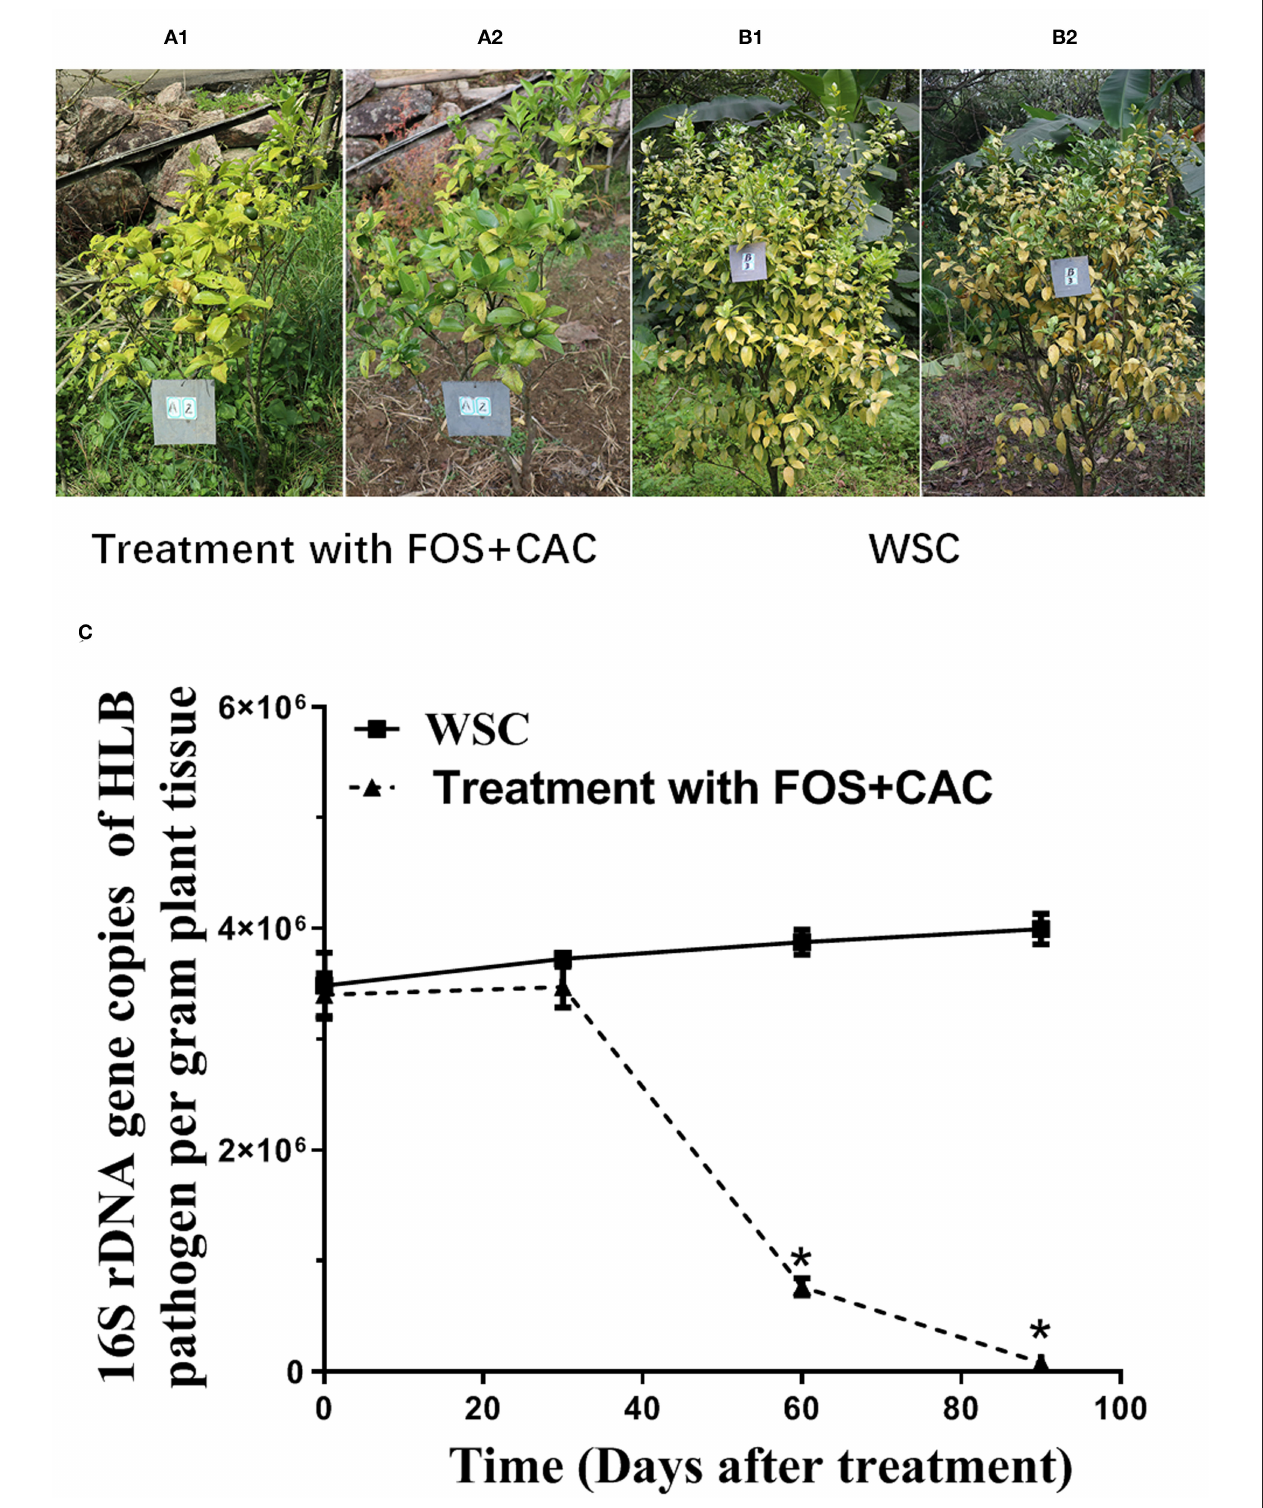
FIGURE 3 | Combination of FOS and CAC effectively relieved citrus HLB after 3 months treatment in the orchard. (A) HLB-affected citrus after 3 months treatment. A1: before treatment; A2:3 months after FOS and CAC treatment. (B) HLB-affected citrus after 3-month without treatment. B1: before treatment; B2:3 months after water treatment. (C) 16S rDNA gene copies of Ca .Las per gram plant leaves midrib during 3 months in the orchard. Standard curve were obtained: Y = − 0.310X + 10.927, R 2 = 0.9965, Y represents 16S rDNA gene copies of HLB pathogen, X represents Ct value. WSC means water soak as control. An asterisk (*) indicates a significant difference ( P < 0.05; Dunnett’s test) between WSC and treatment with two drugs.